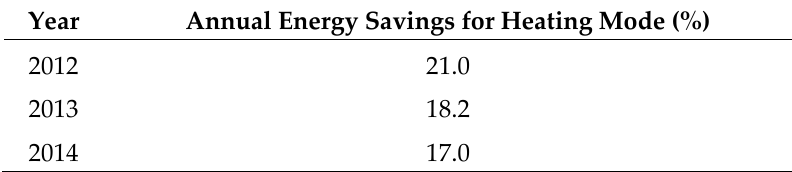
Table 3. Annual natural gas savings in heating mode from eQUEST simulation.